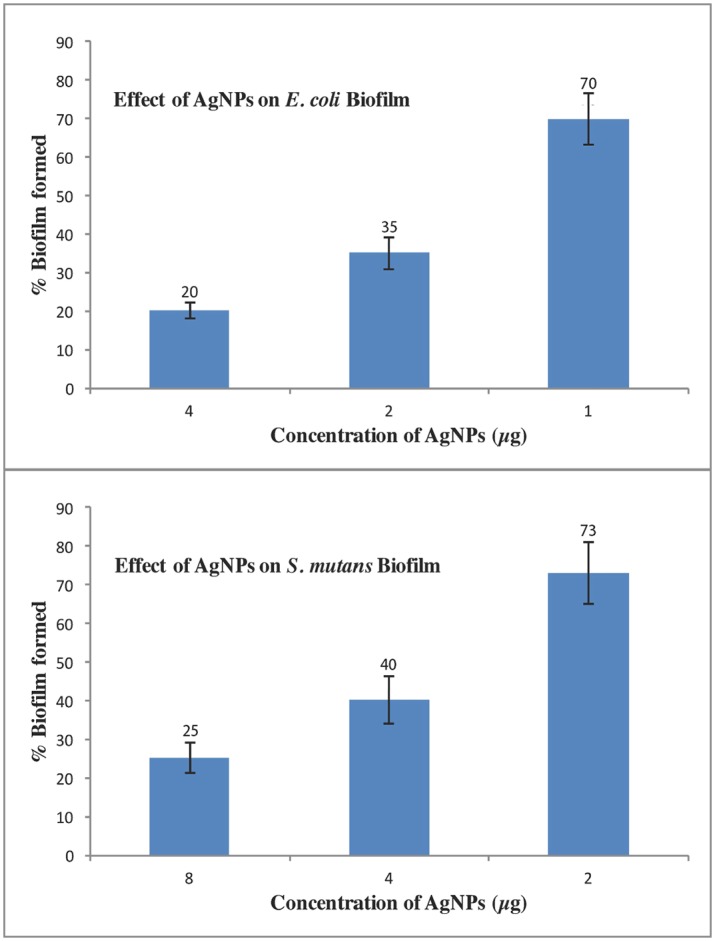
AgNPs antibiofilm activity against biofilms of E. coli and S. mutans.Error bars represent standard deviations of triplicate incubations.